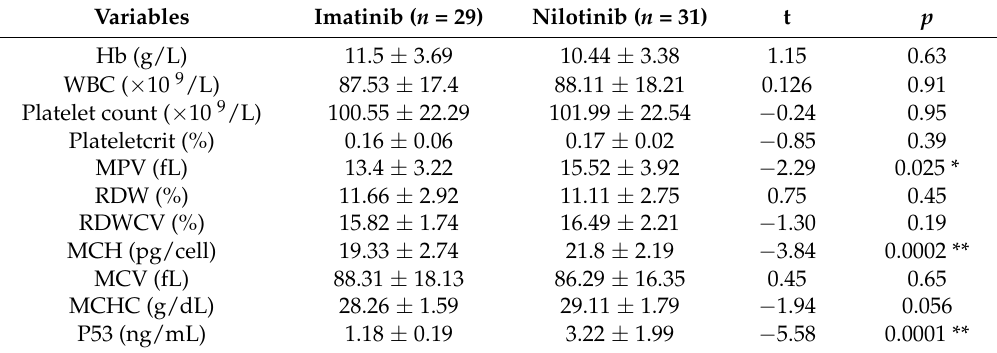
Table 3. The differential effects of imatinib and nilotinib on the hematological profile and p53 gene level in patients with